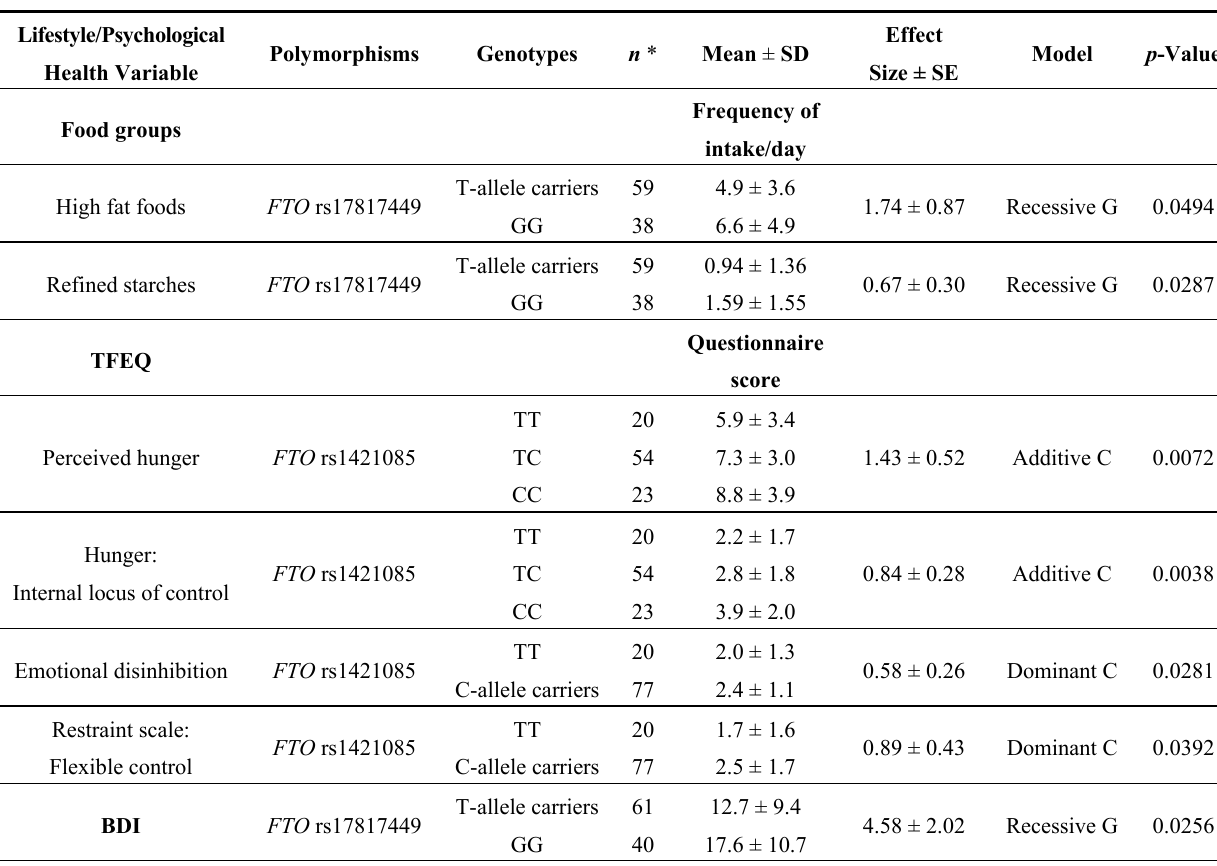
Table 3. Significant associations between genotype groups of FTO rs1421085